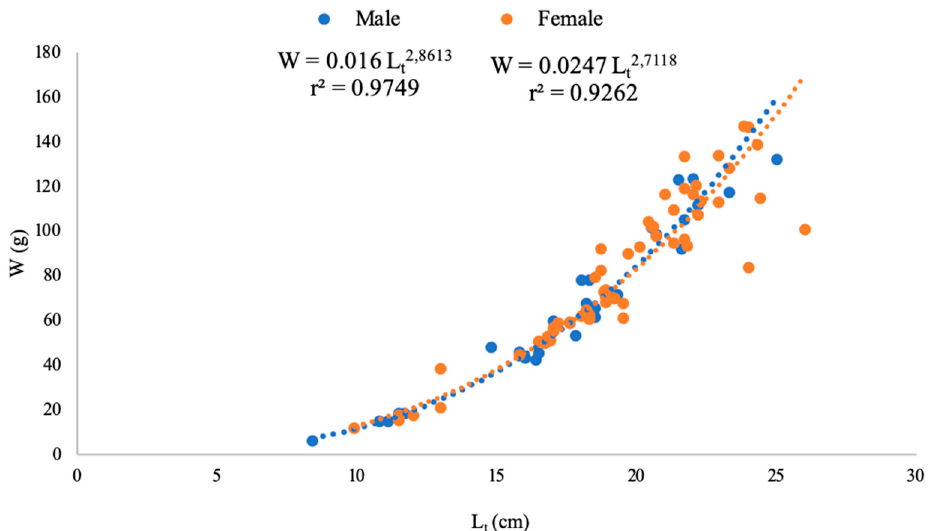
Figure 4. Relationship between total length (L t ) and total weight (W) in S. fontinalis specimens (males and females). Table 5. Age class, sex, and relative K mean (mean ± standard deviation) for S. fontinalis .